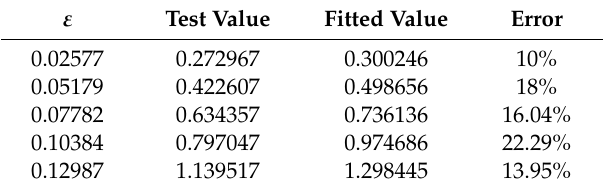
Table 12. The deviation between the test and calculated values for specimen 2 under 300 ◦ C.